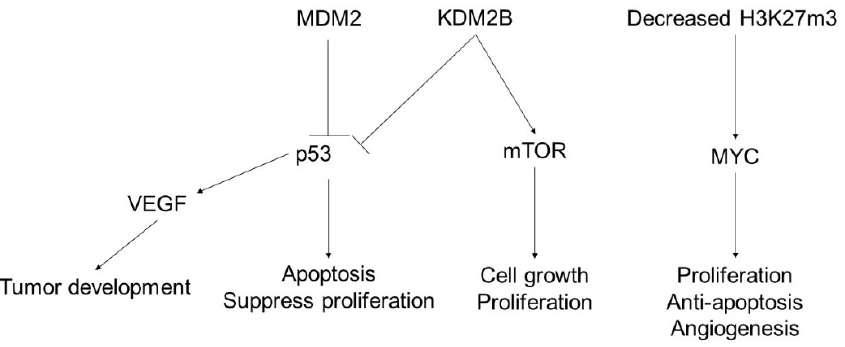
Figure 1. The pathogenesis of angiosarcoma and the influence of epigenetics.